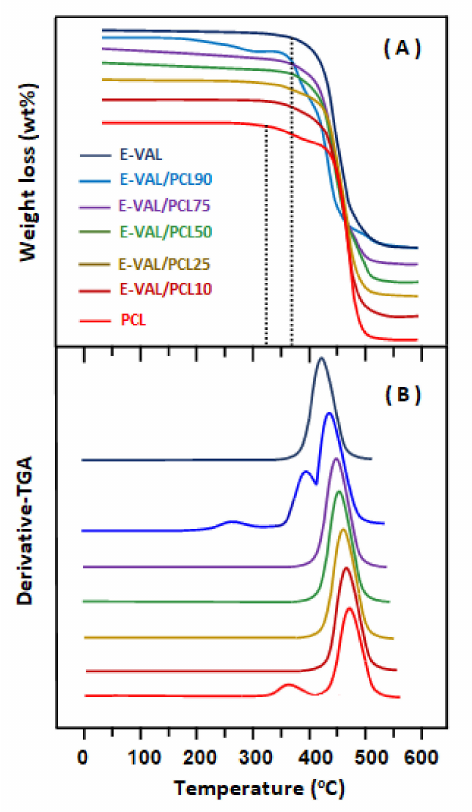
Figure 8. ( A ) TGA and ( B ) DTGA thermograms of pure E-VAL, pure PCL, and E-VAL/PCL with different E-VAL